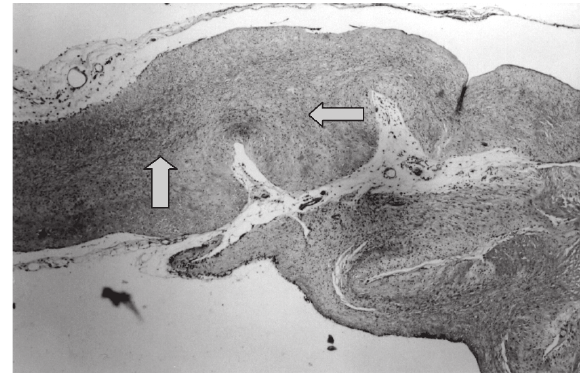
Fig. 3 - Fotomicrografia mostrando corte transversal da cúspide aórtica tratada com ácido L-glutâmico, com sinais de importante calcificação após 15 dias de implante. AG subgrupo 15 dias (H&E 40x).